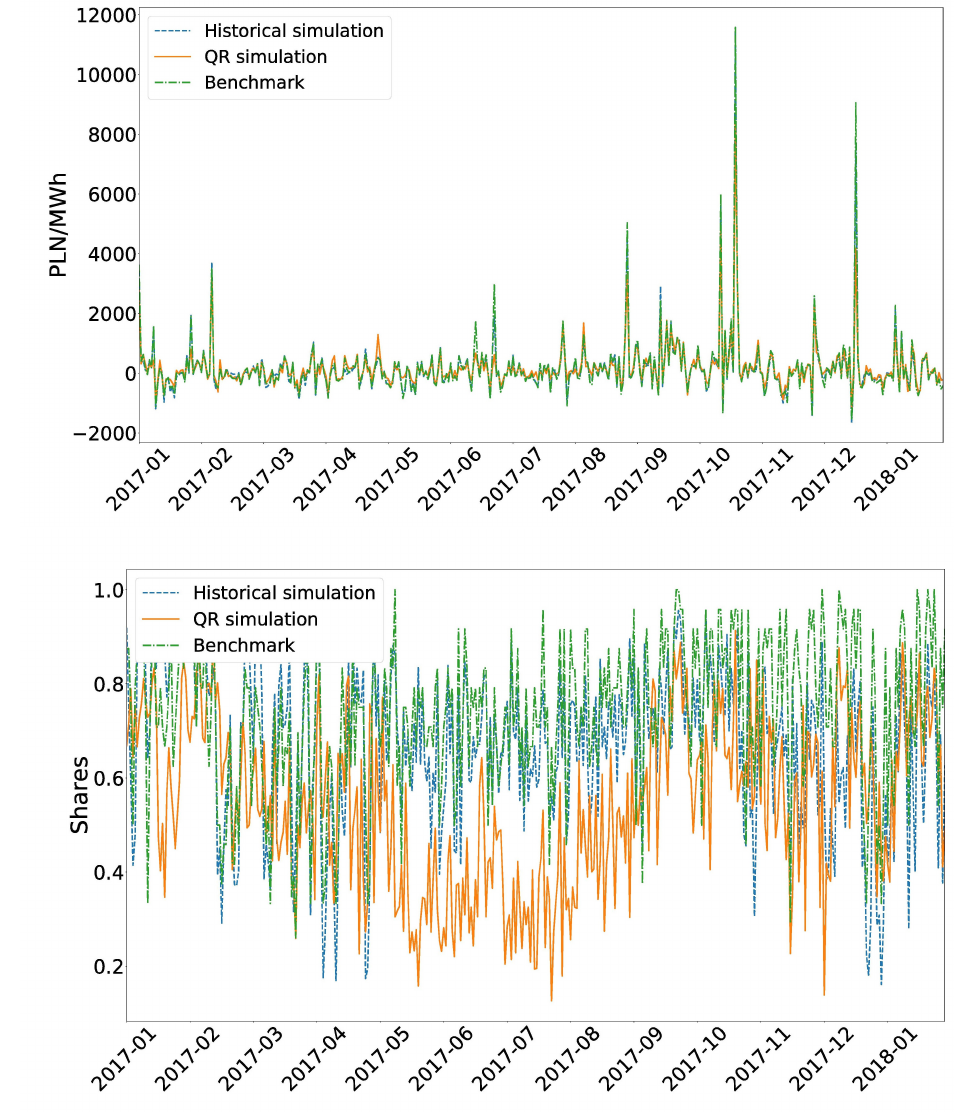
Figure 4. Daily profits from the benchmark strategy and the strategy based on maximization of the median of the future portfolios value ( top panel ). Daily shares of sale on the balancing market associated with the benchmark strategy and the proposed medians maximization strategy ( bottom panel ). The results of the historical method are plotted for the model structure yielding the highest profit, i.e., with X 2 , X 3 , and L = [ 2 ]